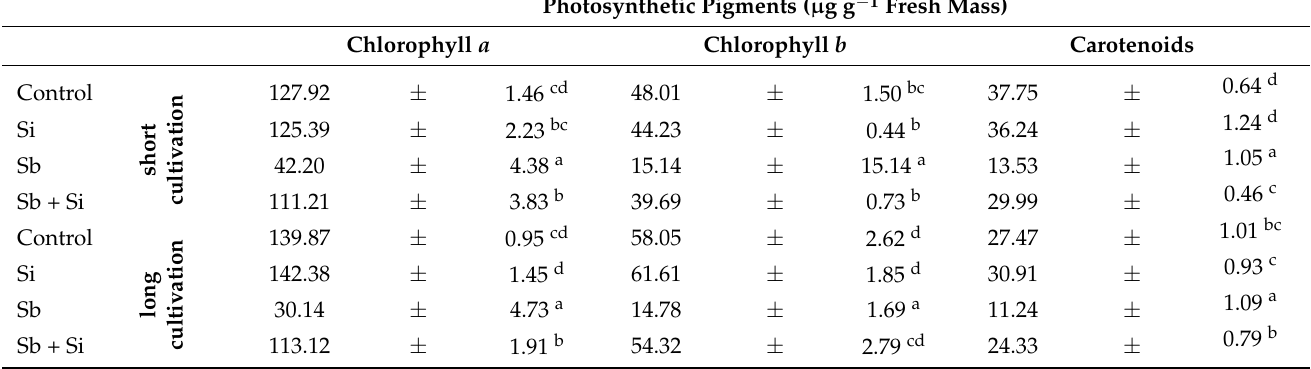
Table 1. Concentration of chlorophyll a ( µ g g − 1 fresh mass), chlorophyll b ( µ g g − 1 fresh mass), and carotenoids ( µ g g − 1 fresh mass) in poplar calli after the short and long cultivations. The data are presented as the means ± standard error ( n = 3). Control—basal medium; Si treatment—basal medium + Si (5 mM); Sb treatment—basal medium + Sb (0.2 mM); Sb + Si treatment—basal medium + Sb (0.2 mM) and Si (5 mM). Different letters (a, b, c, d) denote statistically significant differences